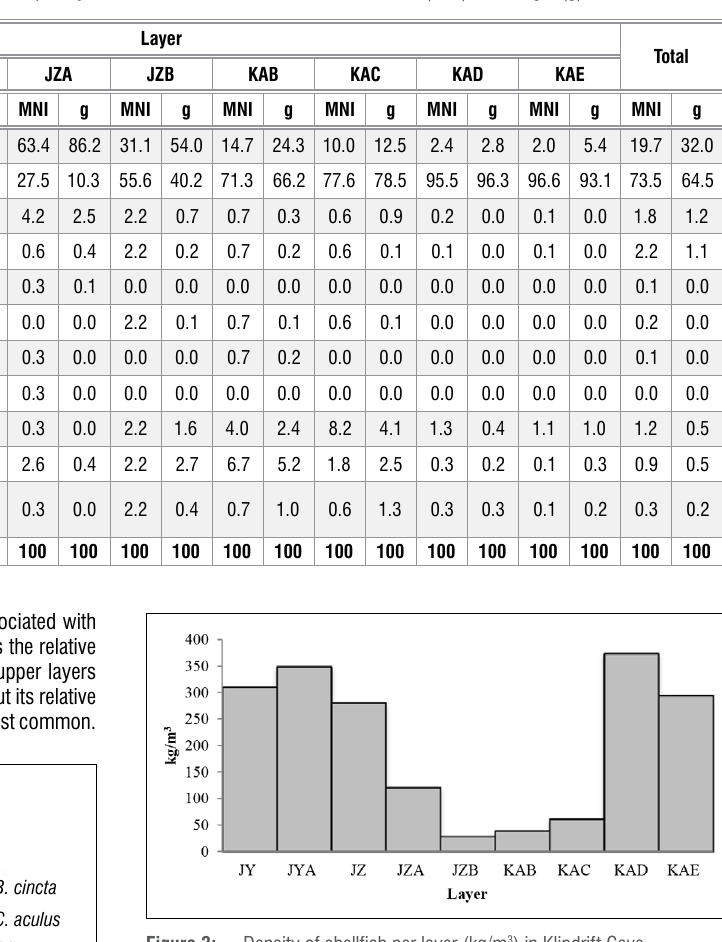
Klipdrift Cave: Turbo sarmaticus opercula descriptive statistics